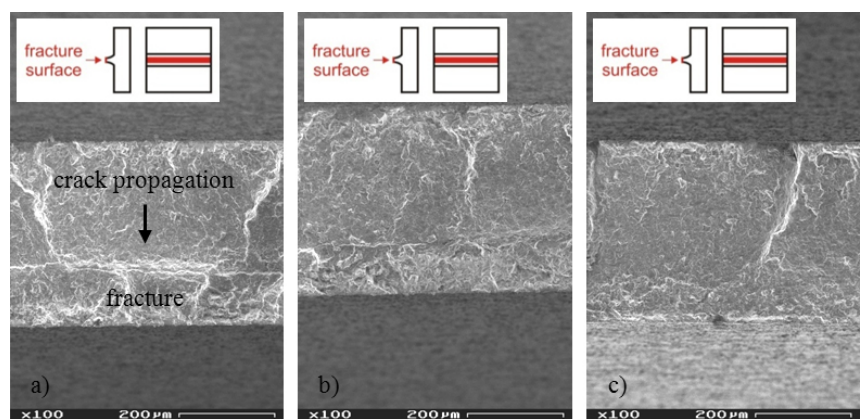
Figure 8. SE images of the fracture surfaces of three specimens: (a) L = 35mm, (b) L = 45mm and (c) L = 60mm.